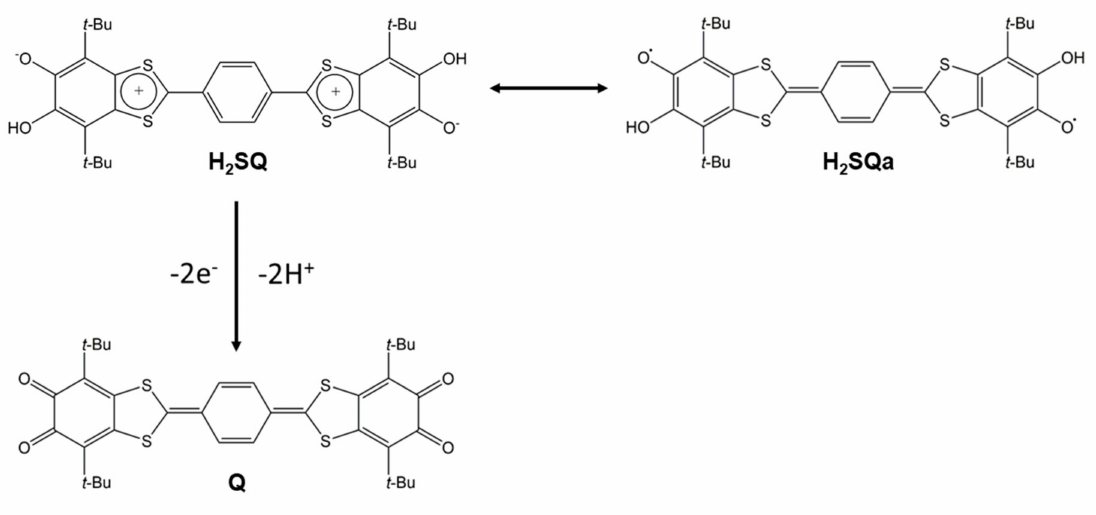
Table S1). The asymmetric unit is composed by one molecule of [Yb 2 (hfac) 6 ( H 2 SQ )] and one half dichloromethane molecule of crystallization. The Yb(hfac) 3 units are linked to the two